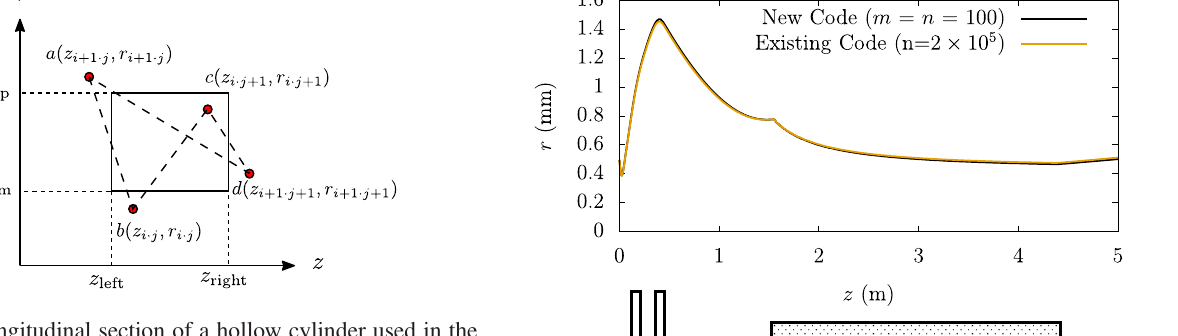
FIG. 13. Longitudinal section of a hollow cylinder used in the new code when intersection occurs.